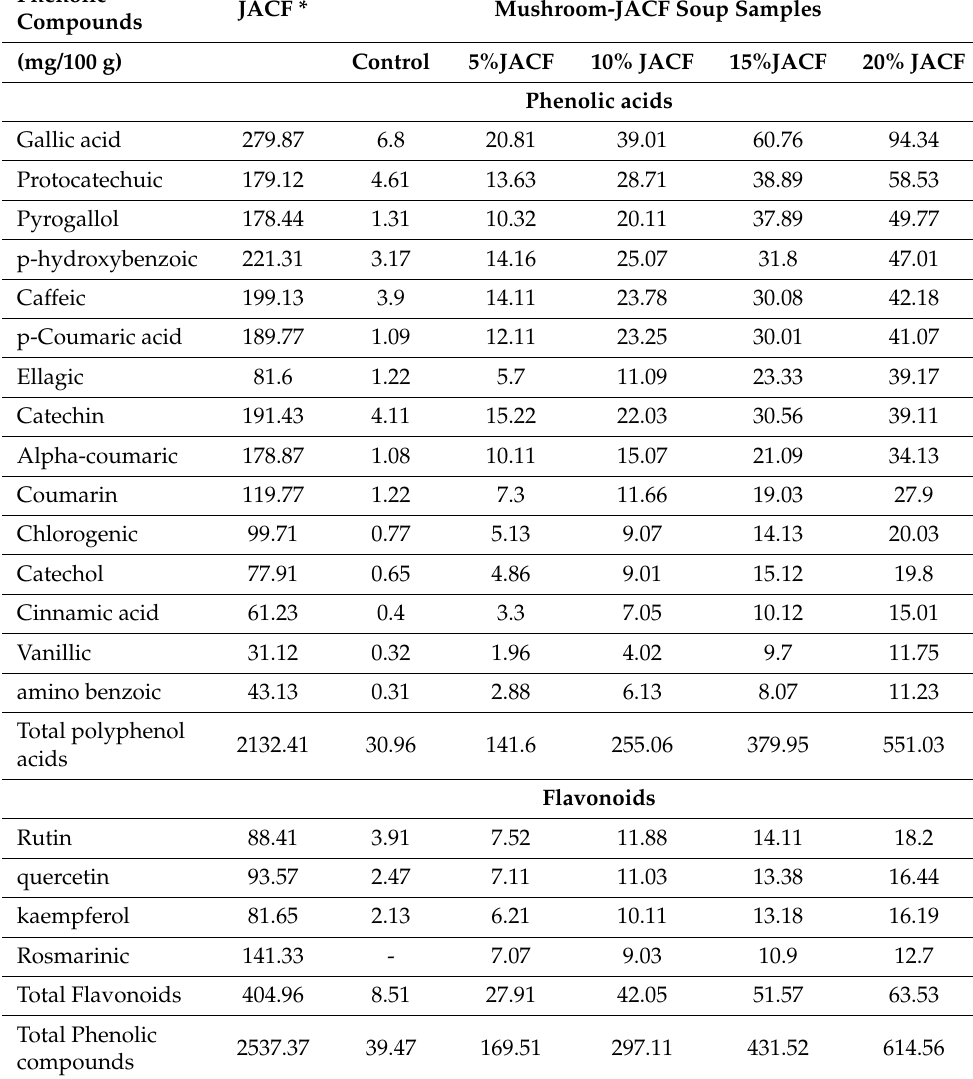
Table 6. HPLC analysis of the phenolic compounds (mg/100 g DW) of the JACF and mushroom-JACF soup